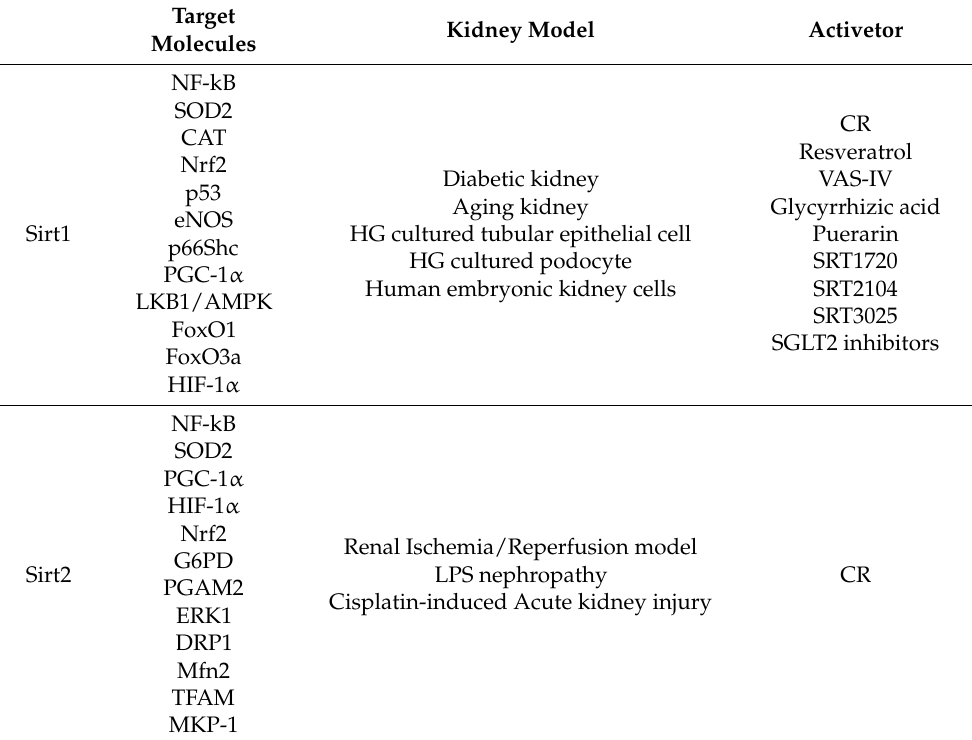
Table 2. Molecules targeted by sirt1 and sirt2 for regulation of the oxidative stress and the activator of sirt1 and